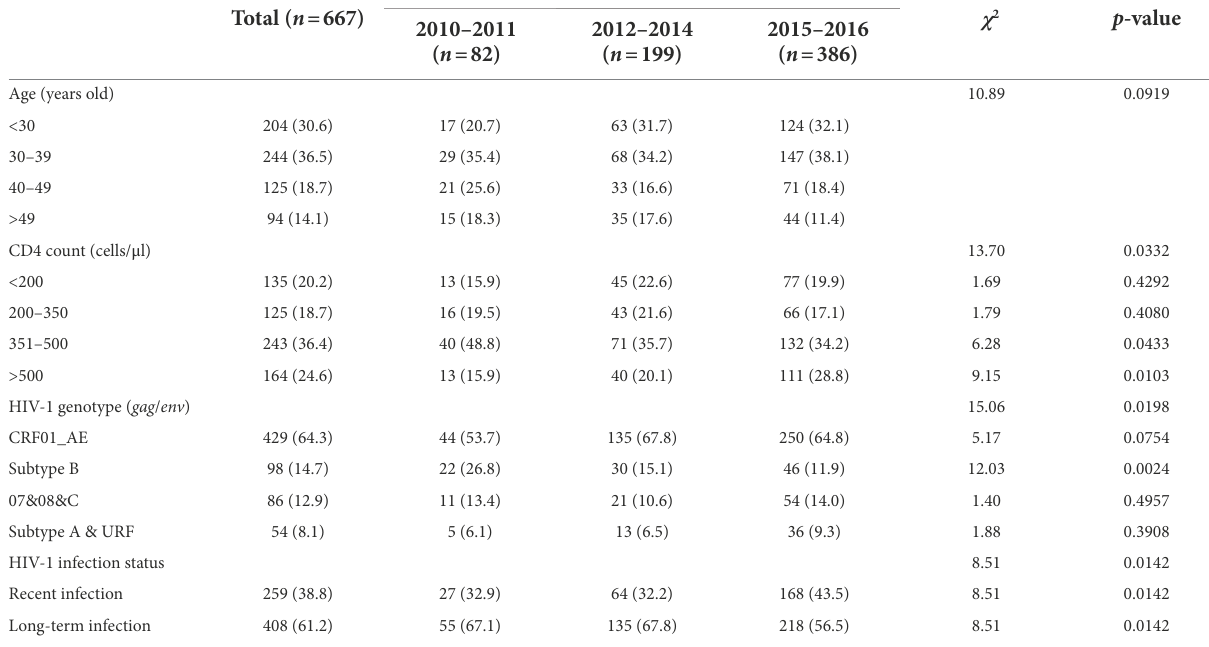
TABLE 2 Basic information of the HIV-1 infected MSM